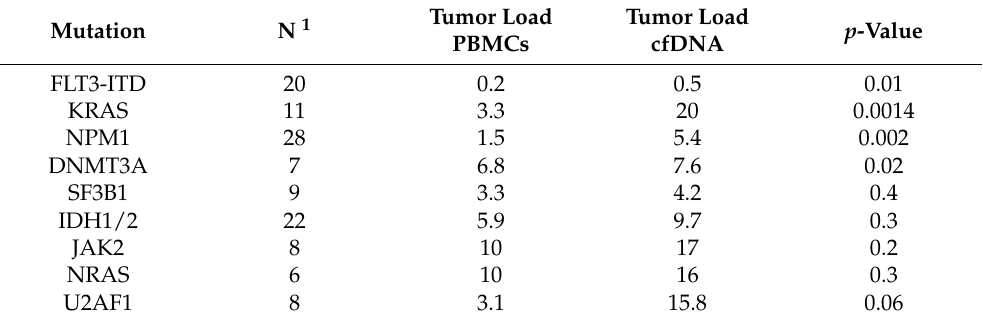
Table 2. Mutation tumor load in PBMCs and